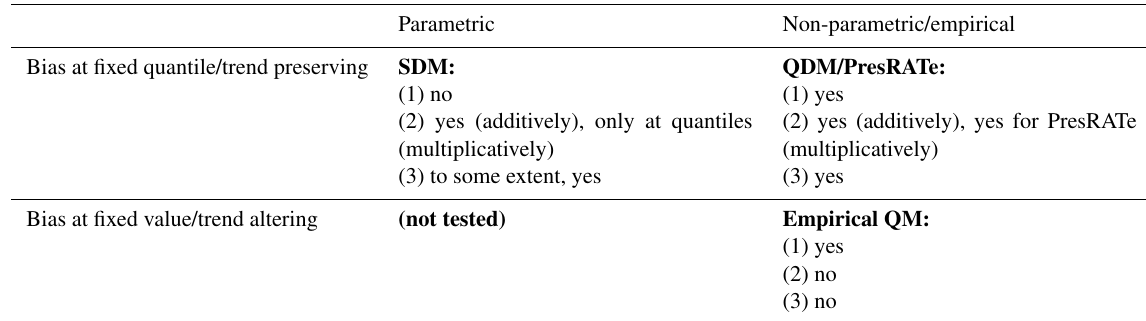
Table 2. As in Table 1. (1), (2) and (3) refer to the demands formulated in the introduction. Parametric